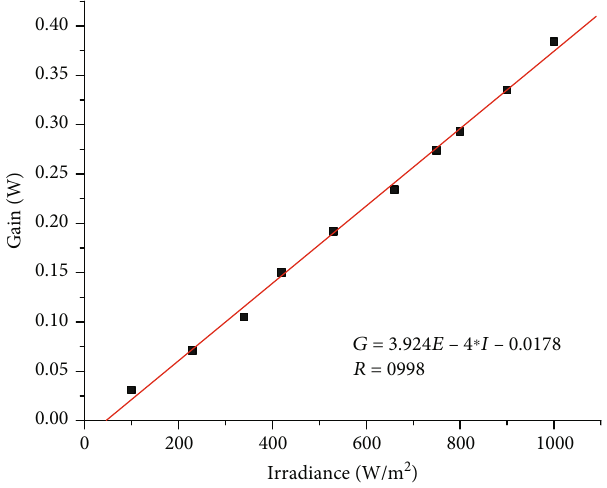
Figure 4: Gain in P max for PV panel in EPR case.